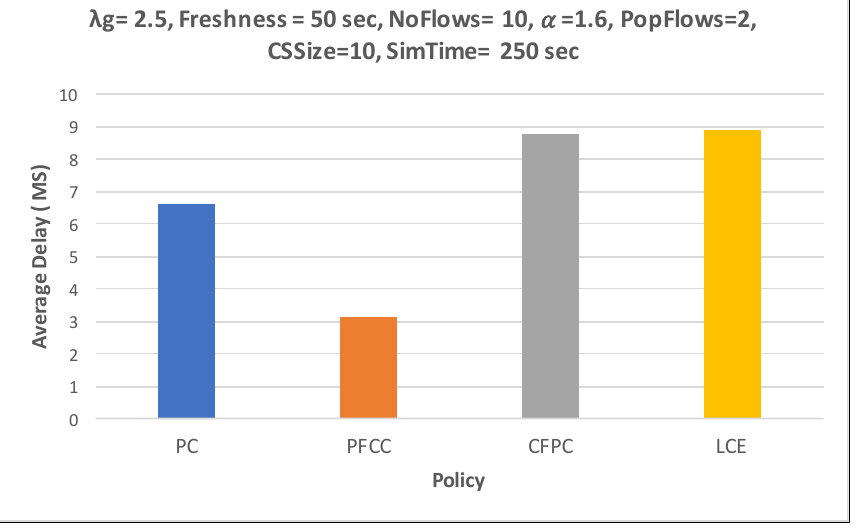
Figure 13. Average delay for popular